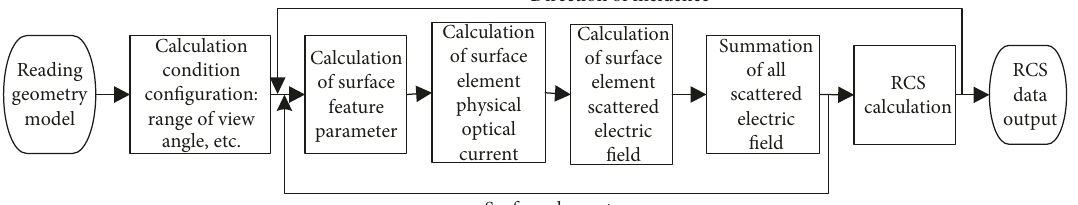
Figure 9: Steps of the low LoF RCS